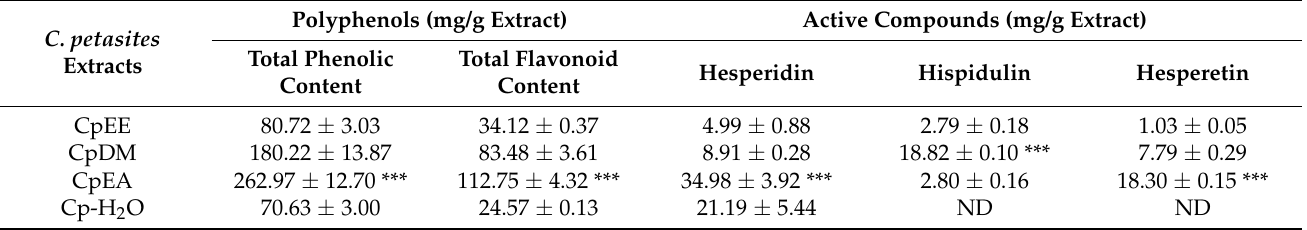
Table 1. Phytochemical characteristics and the identification of active compounds in C. petasites extracts. C.